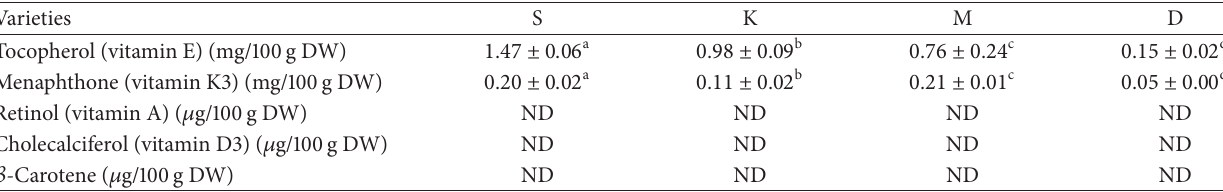
Table 3: Fat-soluble vitamin contents of okra